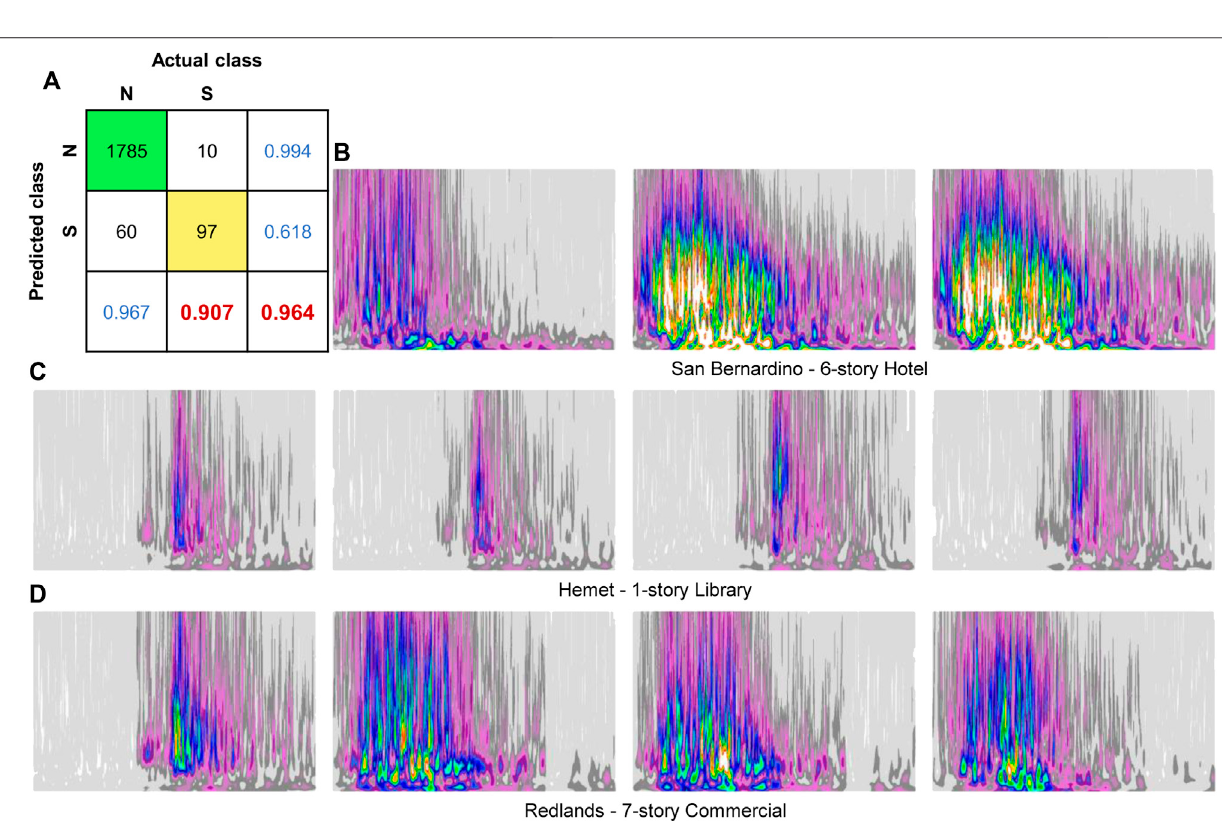
Frontiers in Built Environment |